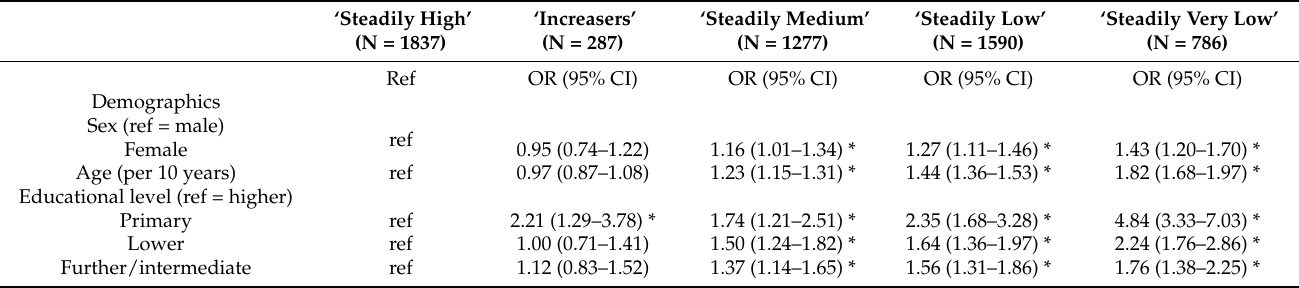
Table 2. Sex- and age adjusted associations of potential determinants with the latent class of physical activity. ‘Steadily High’ (N =